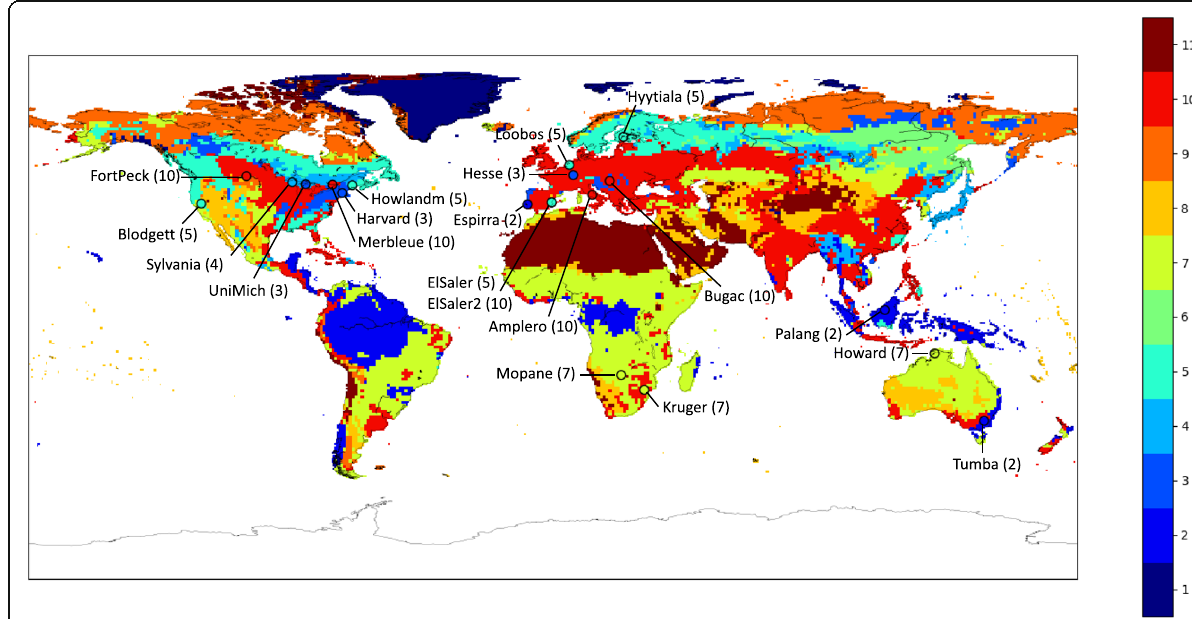
Fig. 6 Locations of 20 Fluxnet sites in PALS land cover types in 0.5° grids are shown on the map. Circles on the map show the locations